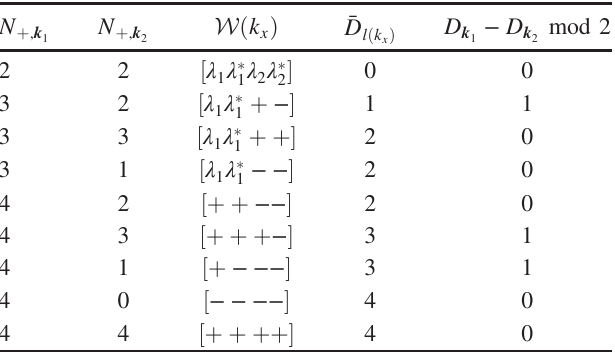
TABLE II. Topological characterization of a crystal with filling f ¼ 4 and either glide or screw symmetry. The notation used here is explained in the caption of Table